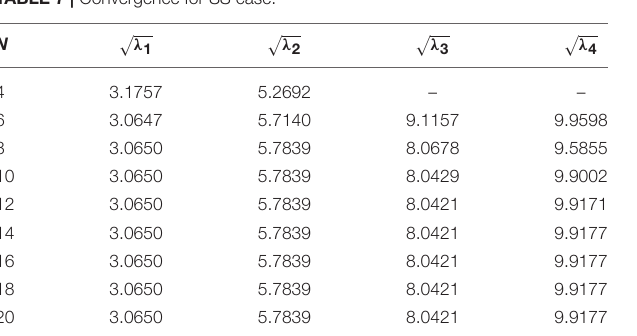
FIGURE 1 | Variation of frequency parameters with number of terms for SS, CS, CC, and CF conditions. (A) Convergence of SS Nanobeam. (B) Convergence of CS Nanobeam. (C) Convergence of CC Nanobeam. (D) Convergence of CF Nanobeam. TABLE 7 | Convergence for SS